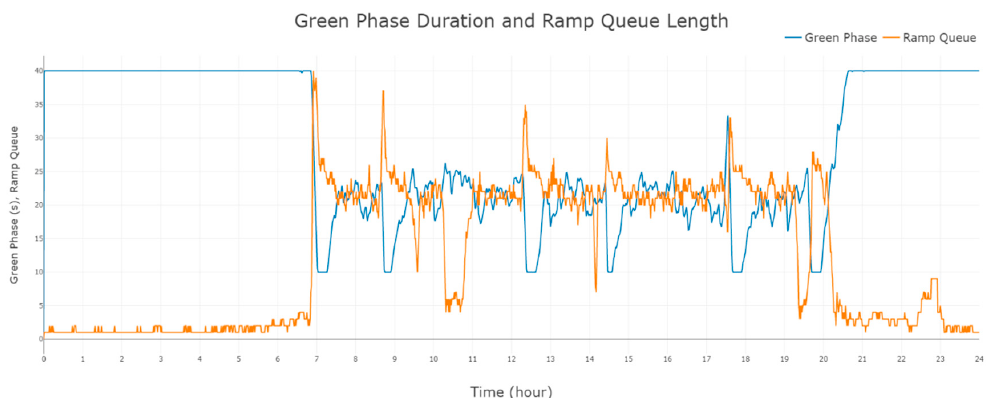
Figure 15. Green phase duration and ramp queue length—ALINEA metering scenario.